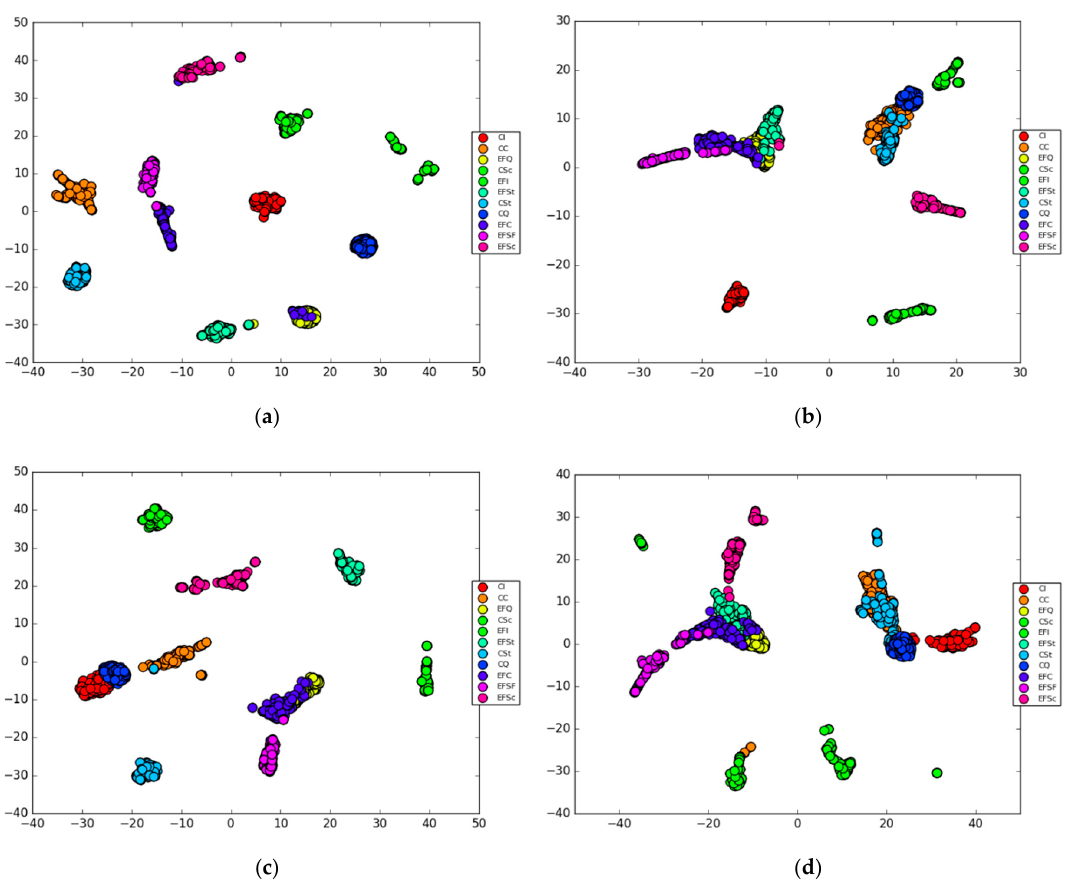
Figure 12. Comparison of t-SNE across the four networks at the end of training: ( a ) Deep SDD-Inception v3; ( b ) Deep SDD-SqueezeNet v1.1; ( c ) Deep SDD-VGG16; ( d ) Deep SDD-ResNet18.